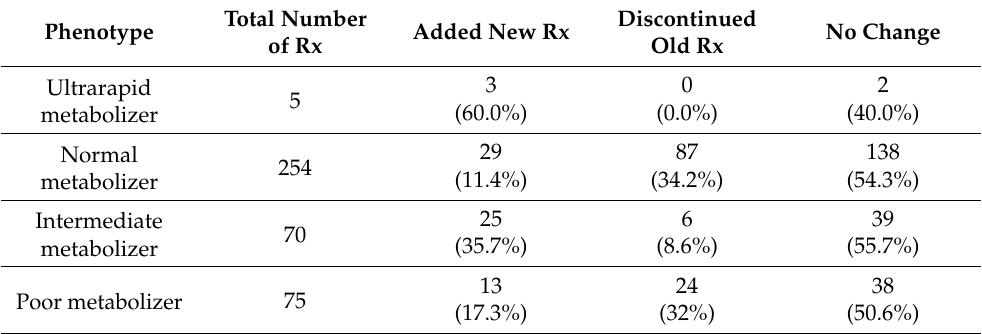
Table 3. Change in pain medication post-CYP2D6 pharmacogenomic testing, stratified by phenotype.